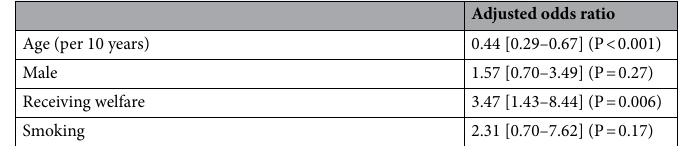
Table 4. Adjusted association of clinical characteristics with lower frequency of meeting with a trusted family member or friend in a subgroup who lived alone ( n = 101). Data are adjusted odds ratios [95% confidence intervals] (P values), derived from the multivariable ordinal regression analysis. The multivariable ordinal regression model included all the variables in the table, which had a statistically significant crude association, and simultaneously had an absolute value of Spearman’s correlation coefficient of larger than 0.2 (see Table